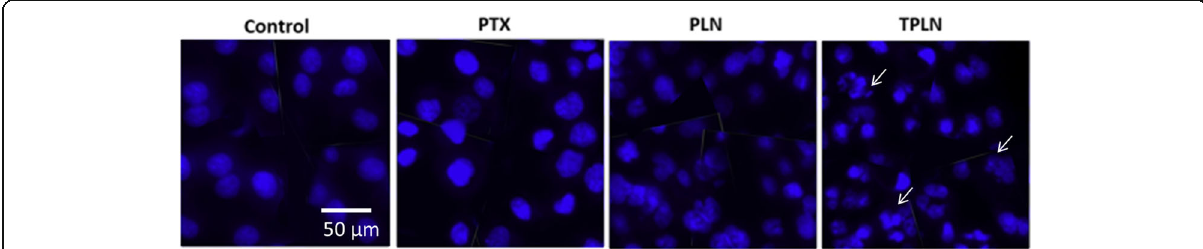
Fig. 6 Hoechst 33342-based apoptosis assay. The cells were stained with Hoechst 33342 and the apoptosis was analyzed by florescence microscope. The cell were incubated with respective formulations for 24 h. Scale bar is 50 μ